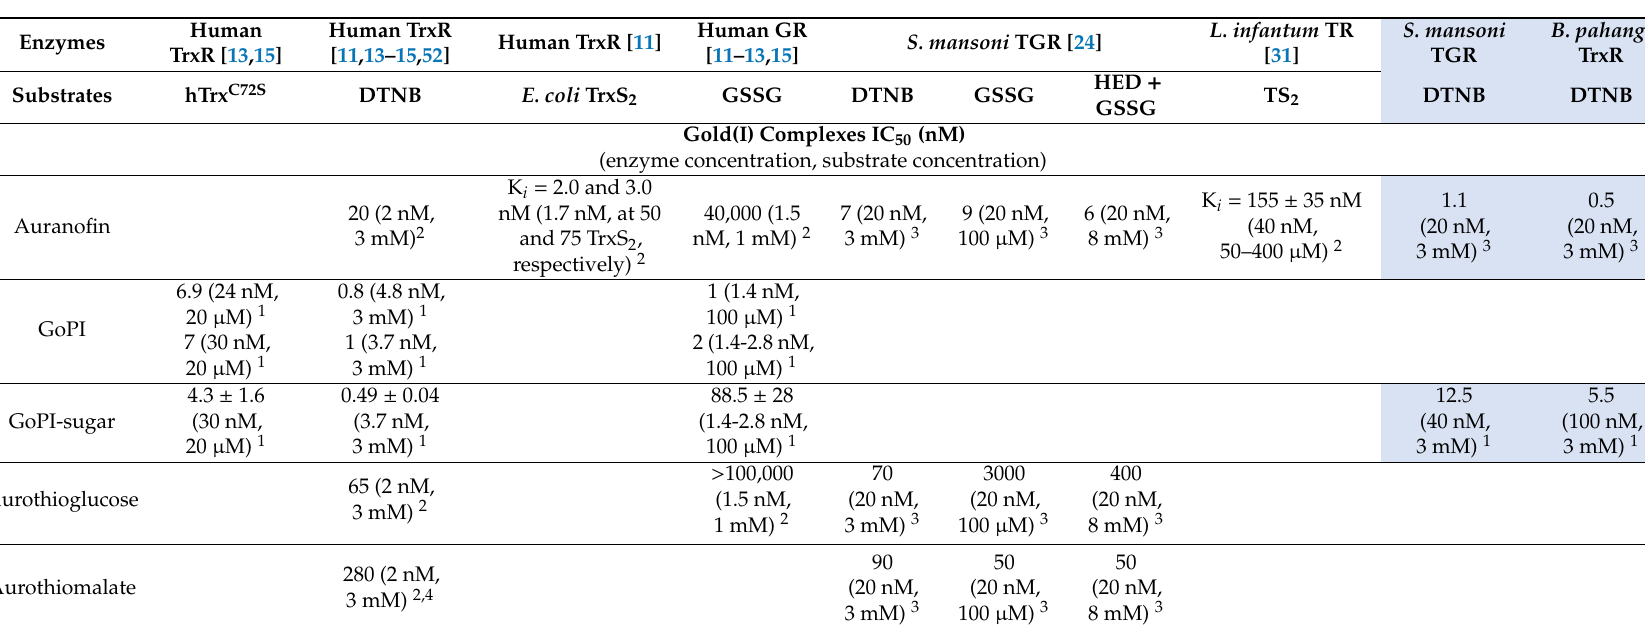
Table 1. Inhibition of human and parasitic NADPH-dependent disulfide reductases: data from the literature and original data (blue background).